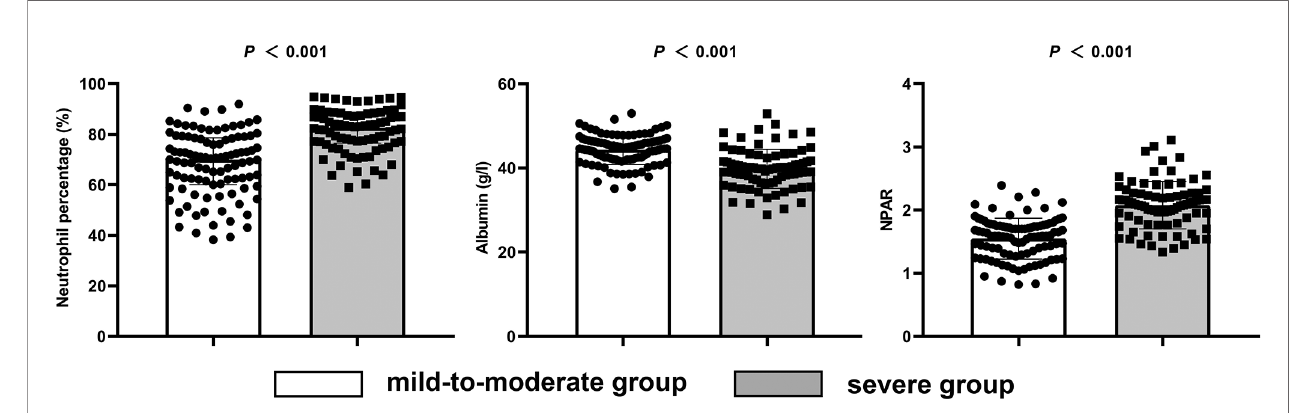
FIGURE 2 | Levels of neutrophil percentage, albumin, and NPAR in the mild-to-moderate and severe admission groups.